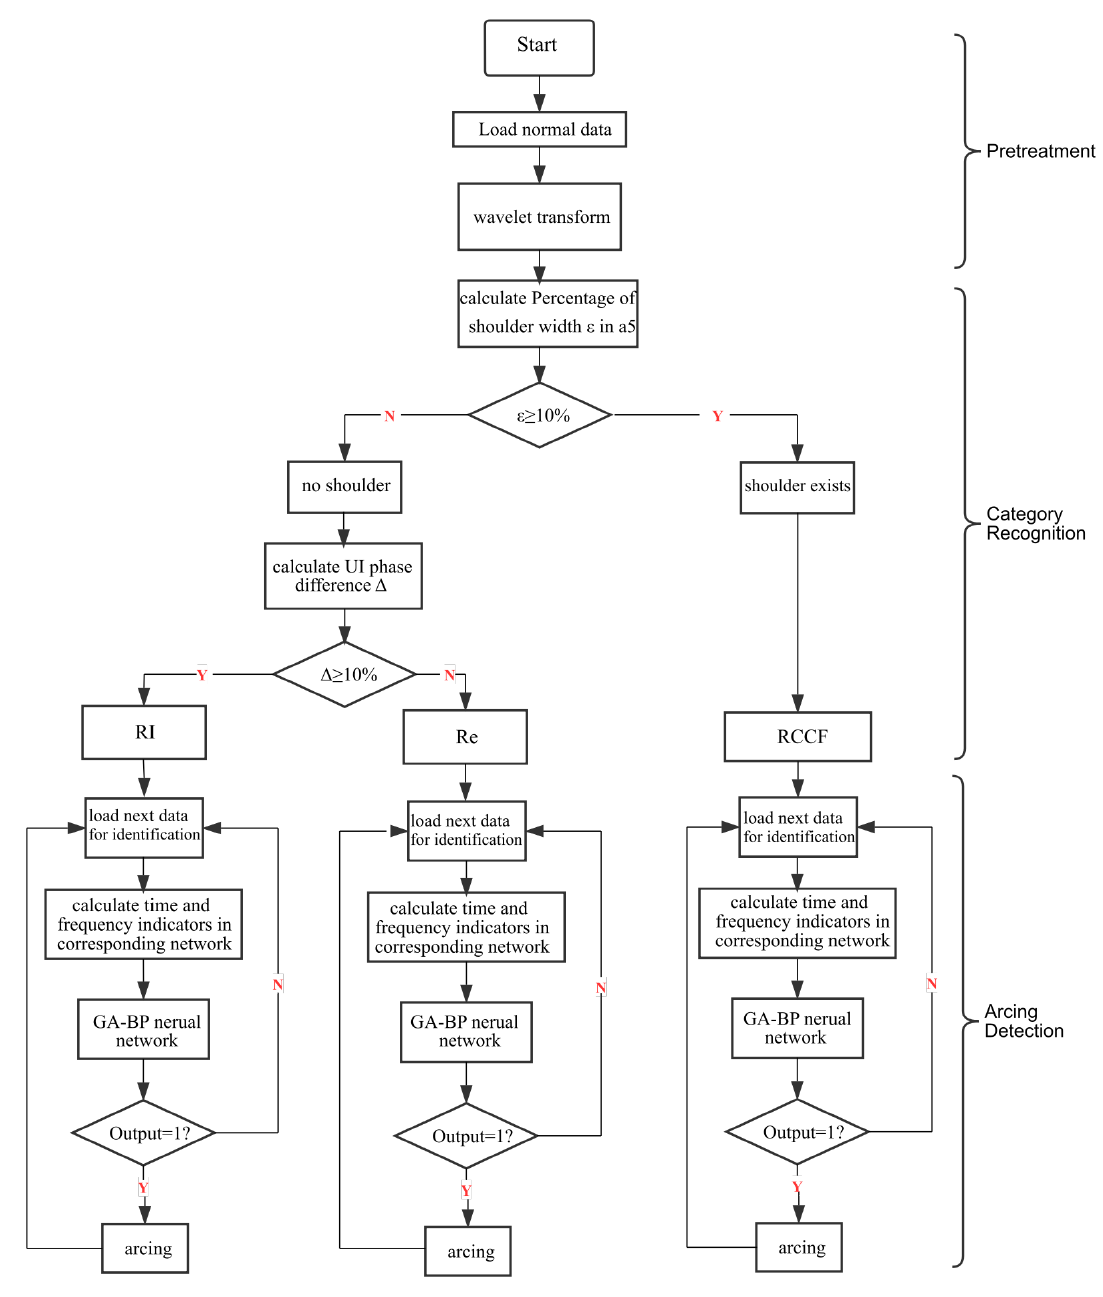
Figure 2. Flow chart of the test method.